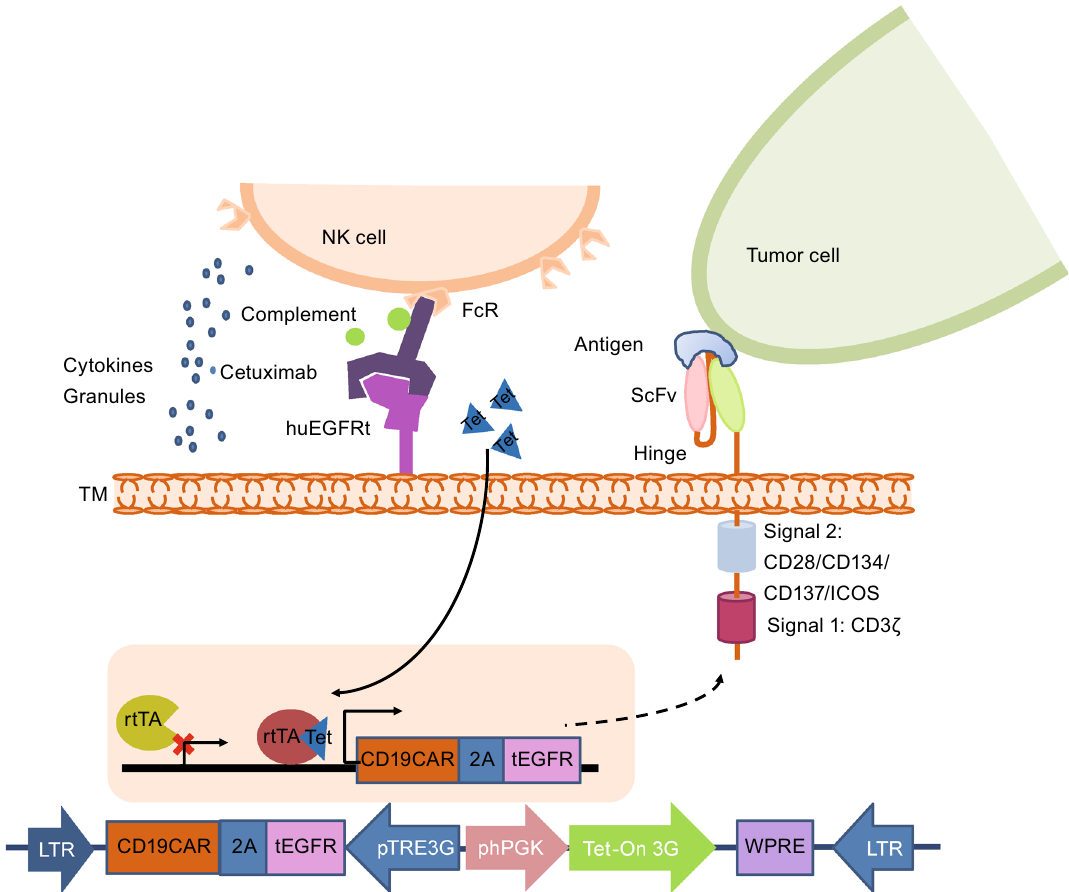
Figure 6. CAR T cells with “ ON/OFF switch ” . The “ ON ” switch utilizes the Tet-On inducible system. Only when tetracycline (Tet) is present, rtTA (r everse t etracycline-controlled t rans a ctivator) binds with Tet and induces the expression of the CAR molecule and marker protein, such as truncated EGFR (tEGFR). The “ OFF ” switch utilizes mAb-mediated ADCC or CDC. Only when the anti- marker protein Ab (such as cetuximab) is present does the mAb bind with the marker protein and mediate ADCC or CDC to lyse CAR T